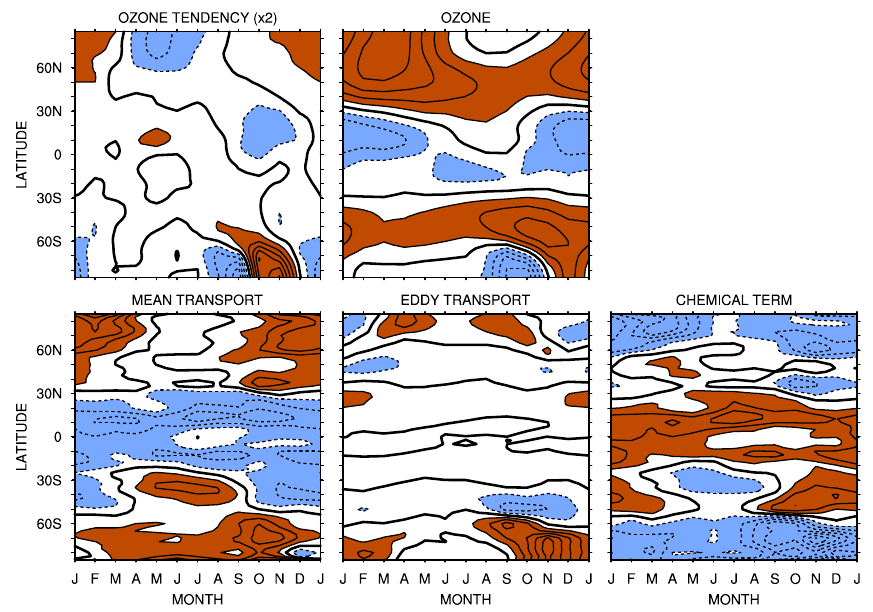
Fig. 1. Annual cycle of the zonal-mean ozone, represented by the departures from the annual global mean over the 22-yr period (2ppmv), and of the zonal-mean ozone tendency and its forcing terms, averaged between 100 and 20hPa. Dashed (solid) lines and blue (brown) colors represent negative (positive) values; the bold solid line represents the zero-line. Contour spacing is 0.2ppmv for the ozone and 10ppbvday − 1 for the ozone tendency and its forcing terms. Note that the ozone tendency is weak compared to its forcing terms and is therefore multiplied by